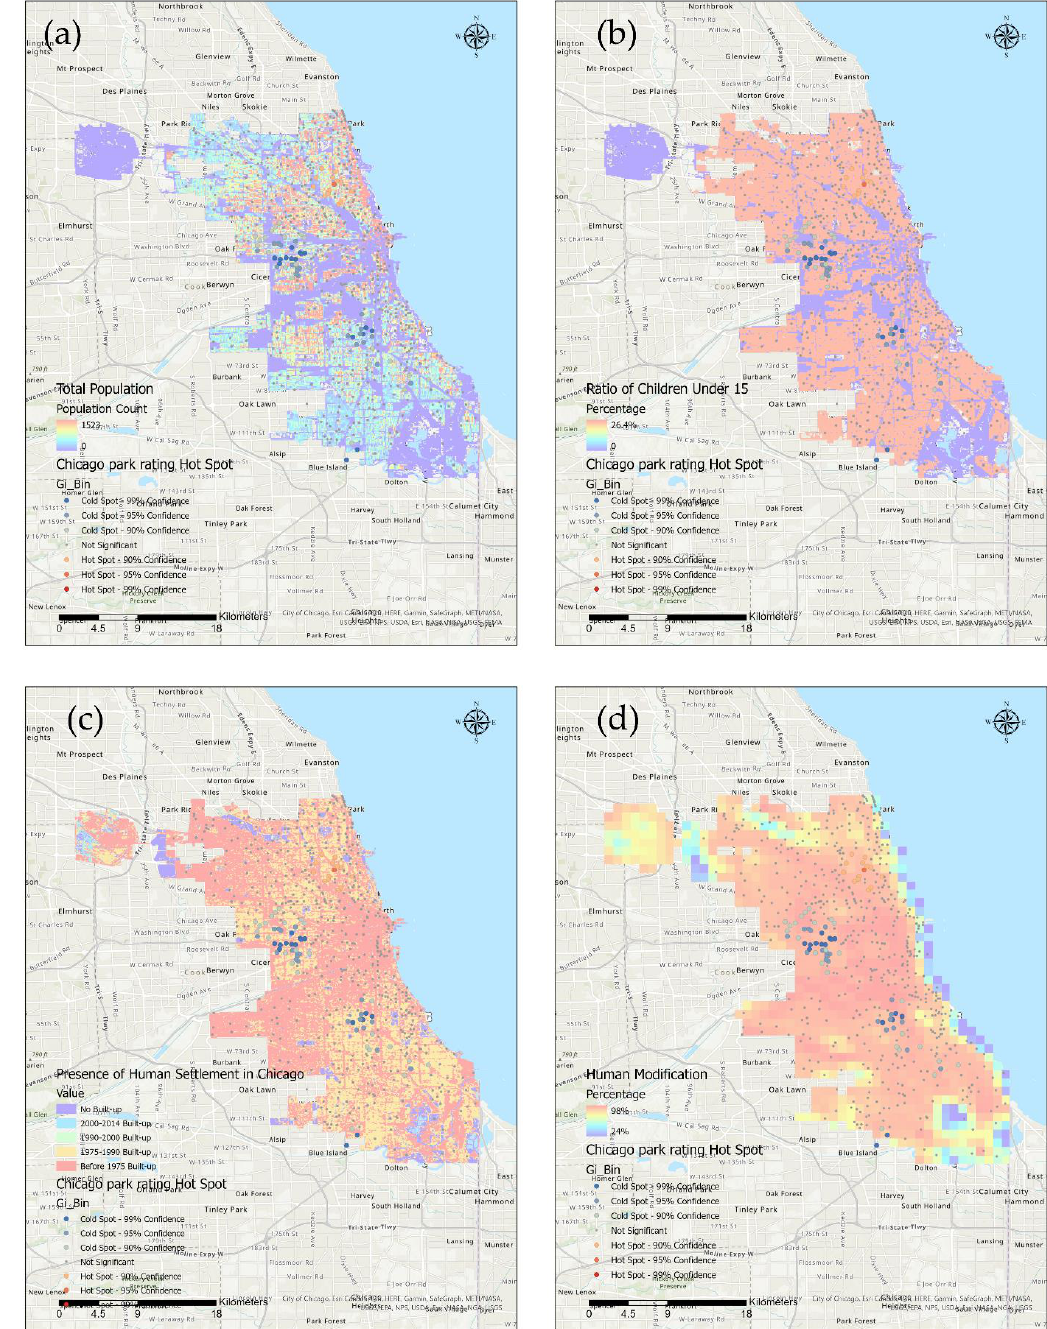
Figure 7. Maps of the relationship between park ratings of Chicago and the spatial patterns of ( a ) the total population of Chicago, ( b ) the percentage of children in the population who are under 15 years old, ( c ) the epoch (before 1975, from 1975–1990, from 1990–2000, and from 2000–2014) of presence of the human built-up, and ( d ) the percentage of human modification (how much human activity has changed the wilderness).